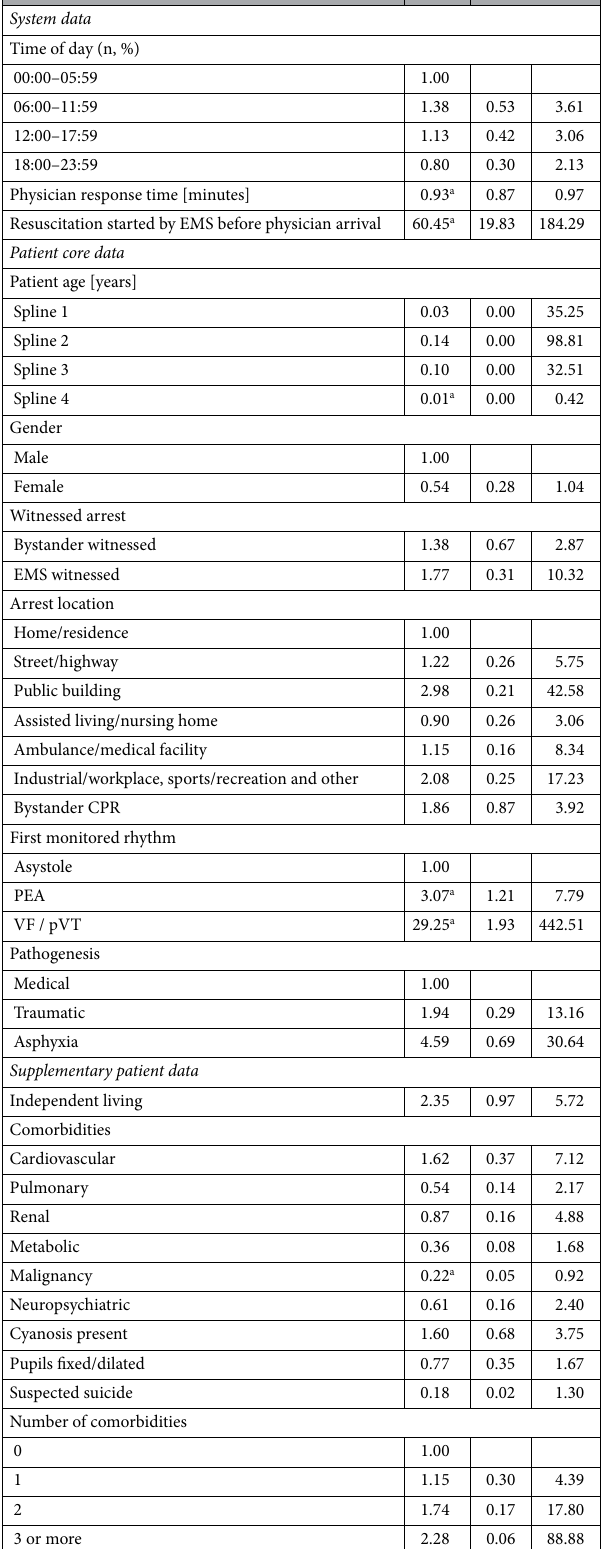
Table 2. Multivariable logistic regression analysis model for start or continuation, if already ongoing, of CPR by the physician as the dependent variable. Included in the model, but not shown: physician ID as random effects. Cross-validated C = 0.892. CI simultaneous confidence interval, EMS emergency medical services, OR odds ratio, pVT pulseless ventricular tachycardia, VF ventricular fibrillation. a Denotes statistically significant